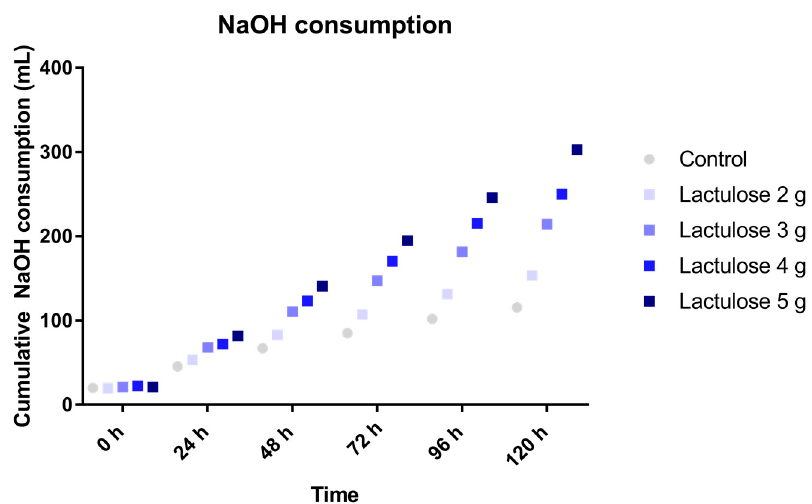
Figure 1. Sodium hydroxide cosumption during TIM-2 runs (mean of n = 2 (Lactulose dosages) or n = 4 (control)) with different dosages of Lactulose. Values at the start of the test period are on average 20.76 mL due to NaOH consumption during the pre-incubation period. All data points shown at the proximity of the individual time points indicated at the X -axis belong to these specific time points.